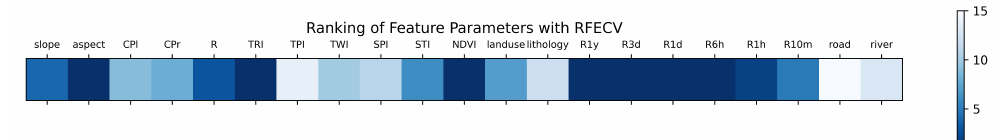
Figure 10. Feature importance in